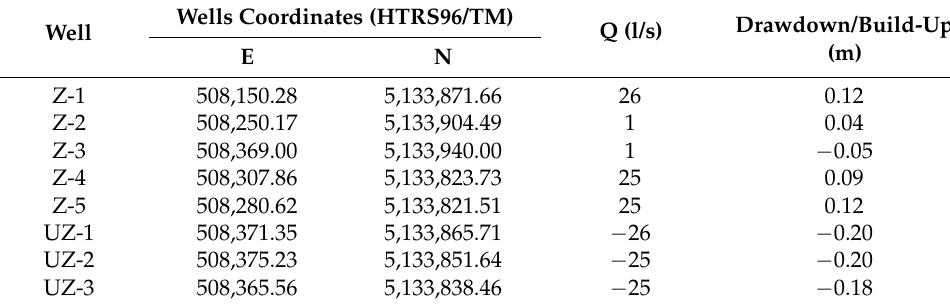
Table 4. Position of wells with discharging/recharging